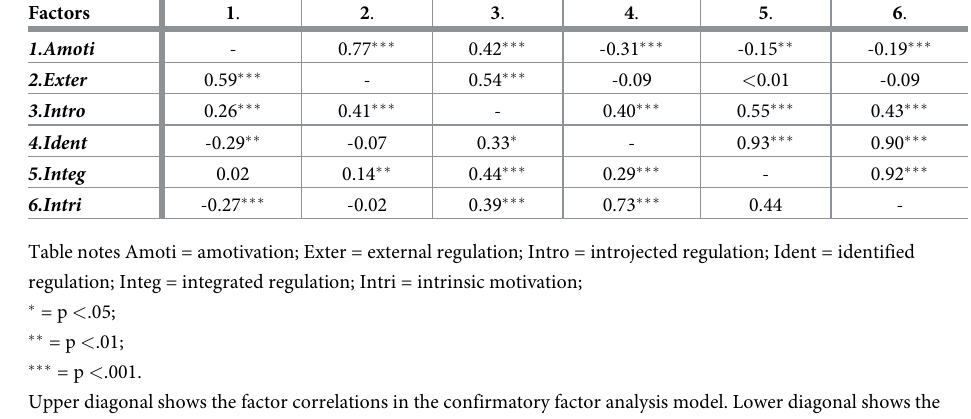
Table 5. Factor correlations for the confirmatory factor analysis and exploratory structural equation models. Factors